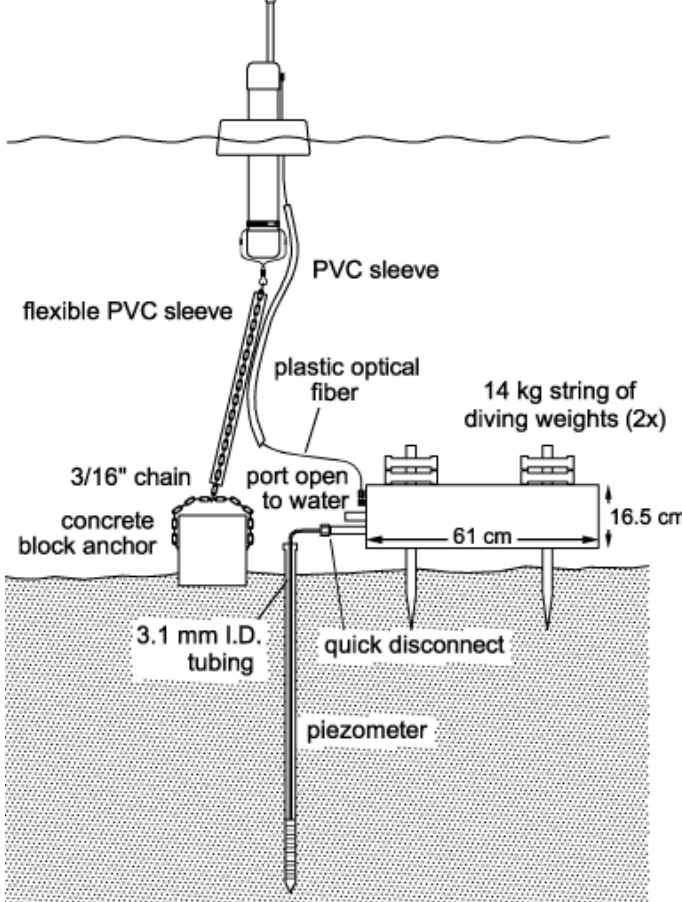
Figure 2. Diagram of a typical deployment of a DP Logger with wireless communication